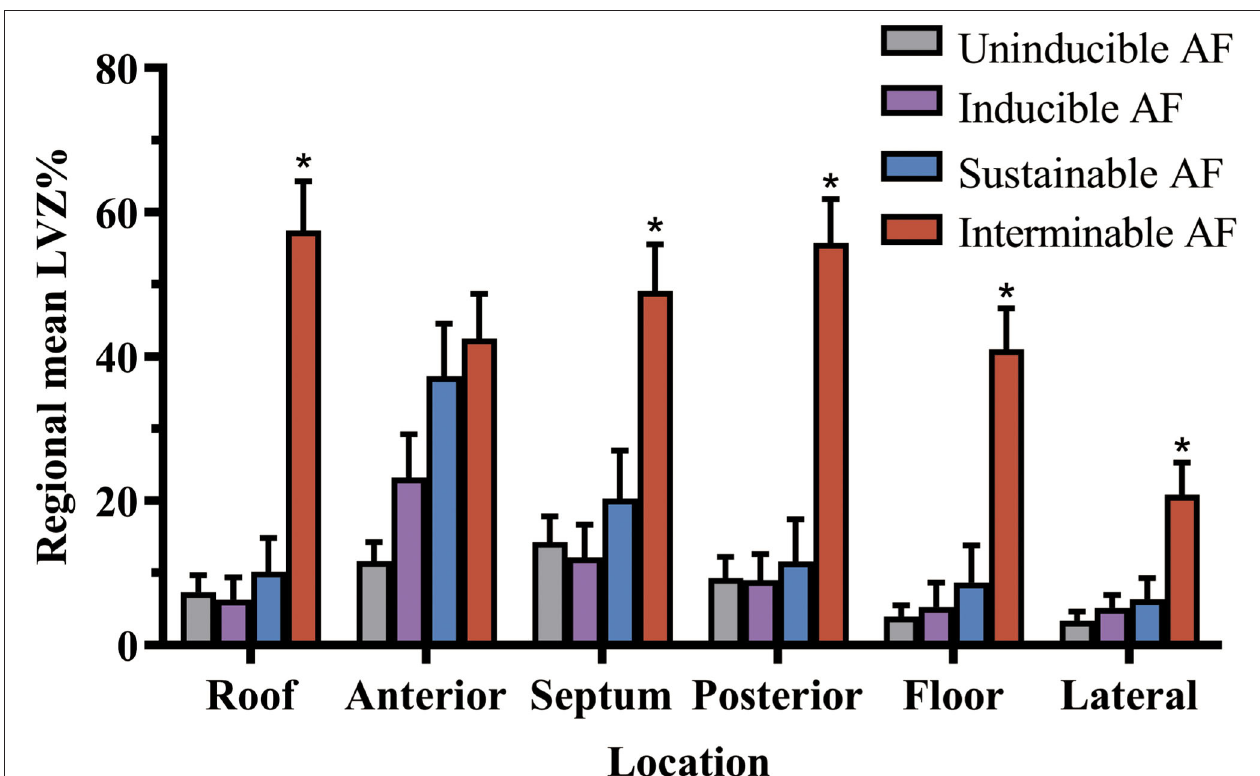
FIGURE 3 | The LVZ distribution of left atrium in the different stages of AF. LVZ% gradually enlarged as AF turned from uninducible into sustainable and interminable. *Compared between sustained and interminable AF patients, p < 0.05. The bar charts were drawn using means and standard error. AF, atrial fibrillation; LVZ, low voltage